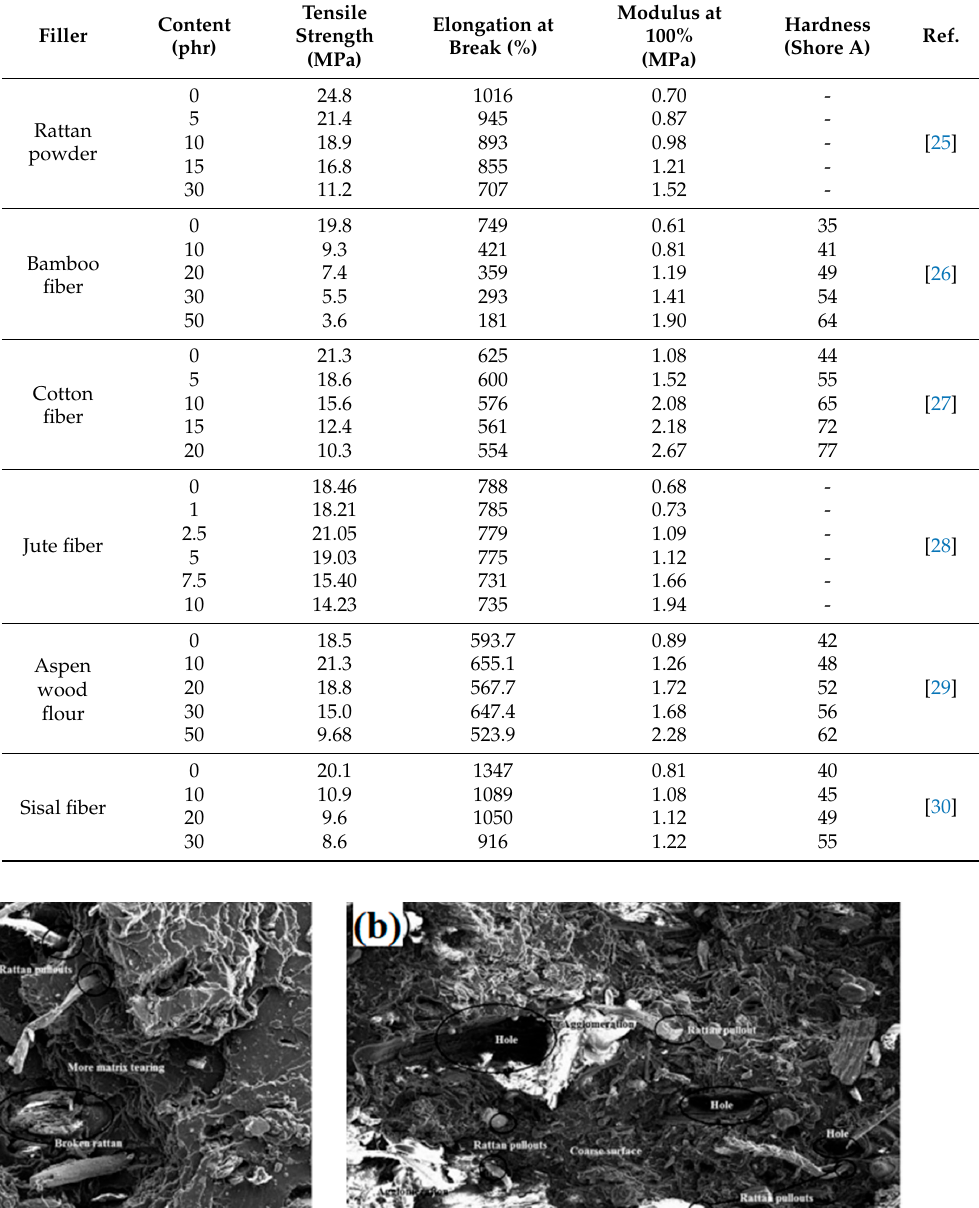
Table 3. Mechanical properties of NR composites filled with different types of natural fibers.